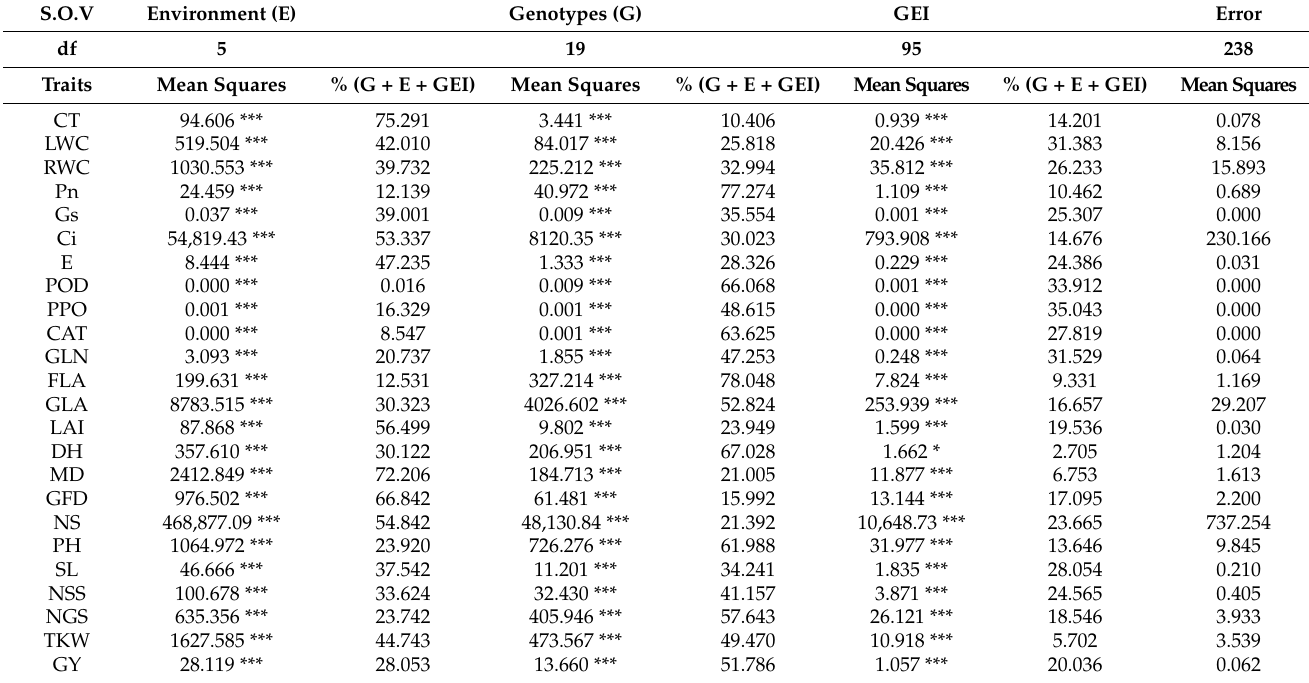
Table 2. Analysis of variance along with their contribution towards total variation for 20 genotypes of wheat for all the traits studied in six test environments.